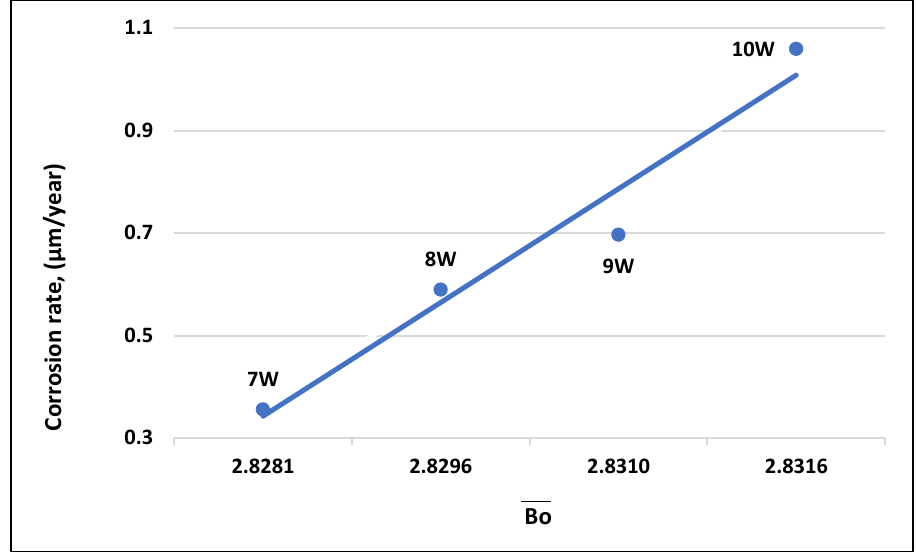
Figure 11. Correlation of corrosion rate, CR (μm/year) with Bo for beta Ti-19Mo-xW alloys.